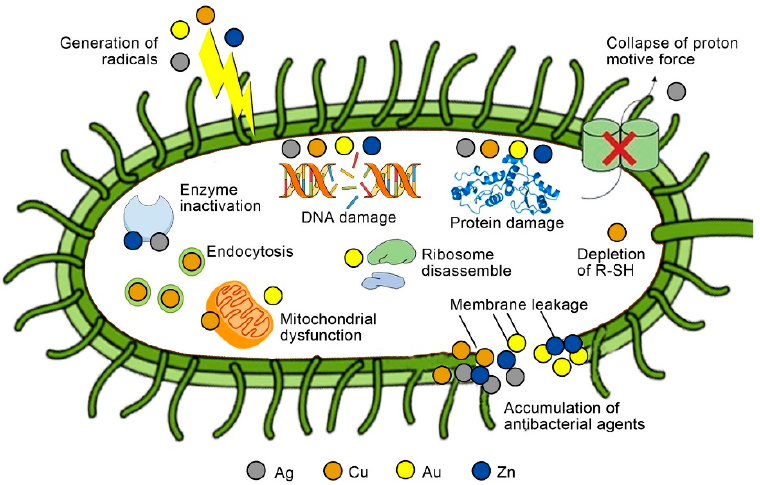
Figure 2. Possible antibacterial mechanisms for inorganic antibacterial agents of Ag, Cu, Au, and Zn. R-SH, sulfhydryls (Reprinted with permission from Ref. [50] Copyright 2021